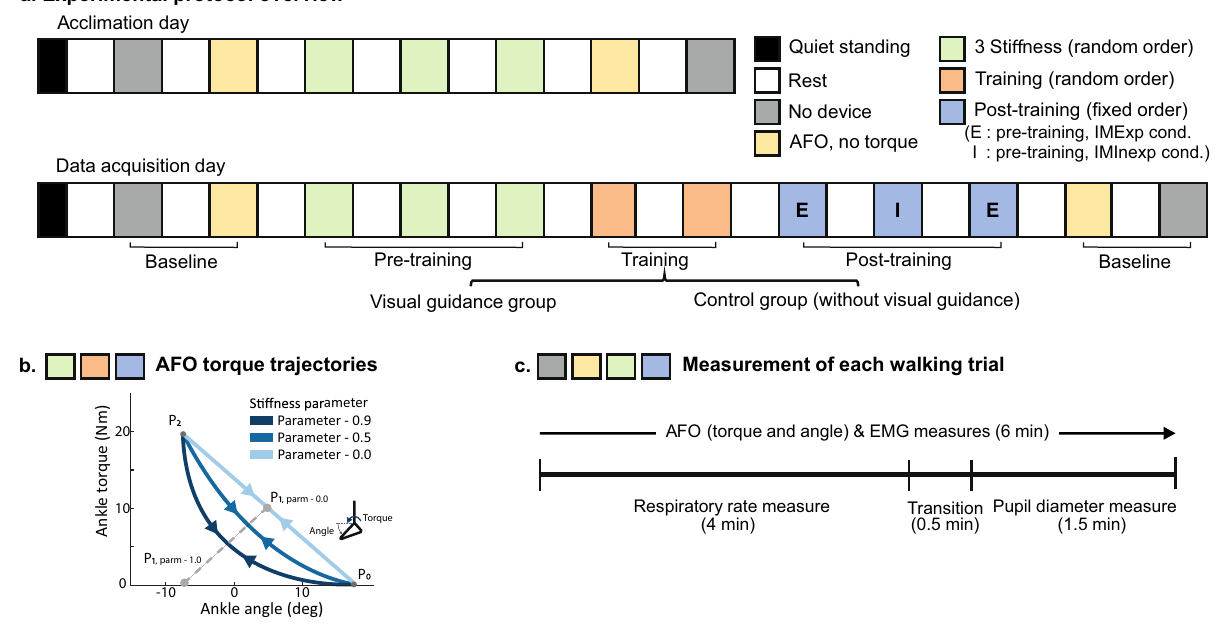
Figure 2. Experimental protocol. ( a ) We conducted two days of experiments; day1: acclimation to a robotic ankle exoskeleton and day2: data acquisition to investigate the effect of visual guidance on ankle exoskeleton use. ( b ) Participants experienced three different ankle exoskeleton torque trajectories as a function of a stiffness parameter on the acclimation day and data acquisition day, pre-training period. After pre-training, initial metabolic inexpensive (I), and metabolic expensive (E) exoskeleton conditions were selected and presented during training and post-training periods. ( c ) We measured respiratory rate for the initial 4 min and pupil diameter for 4.5–6 min. We measured robotic ankle exoskeleton torque and angle and electromyography (EMG) for the entire